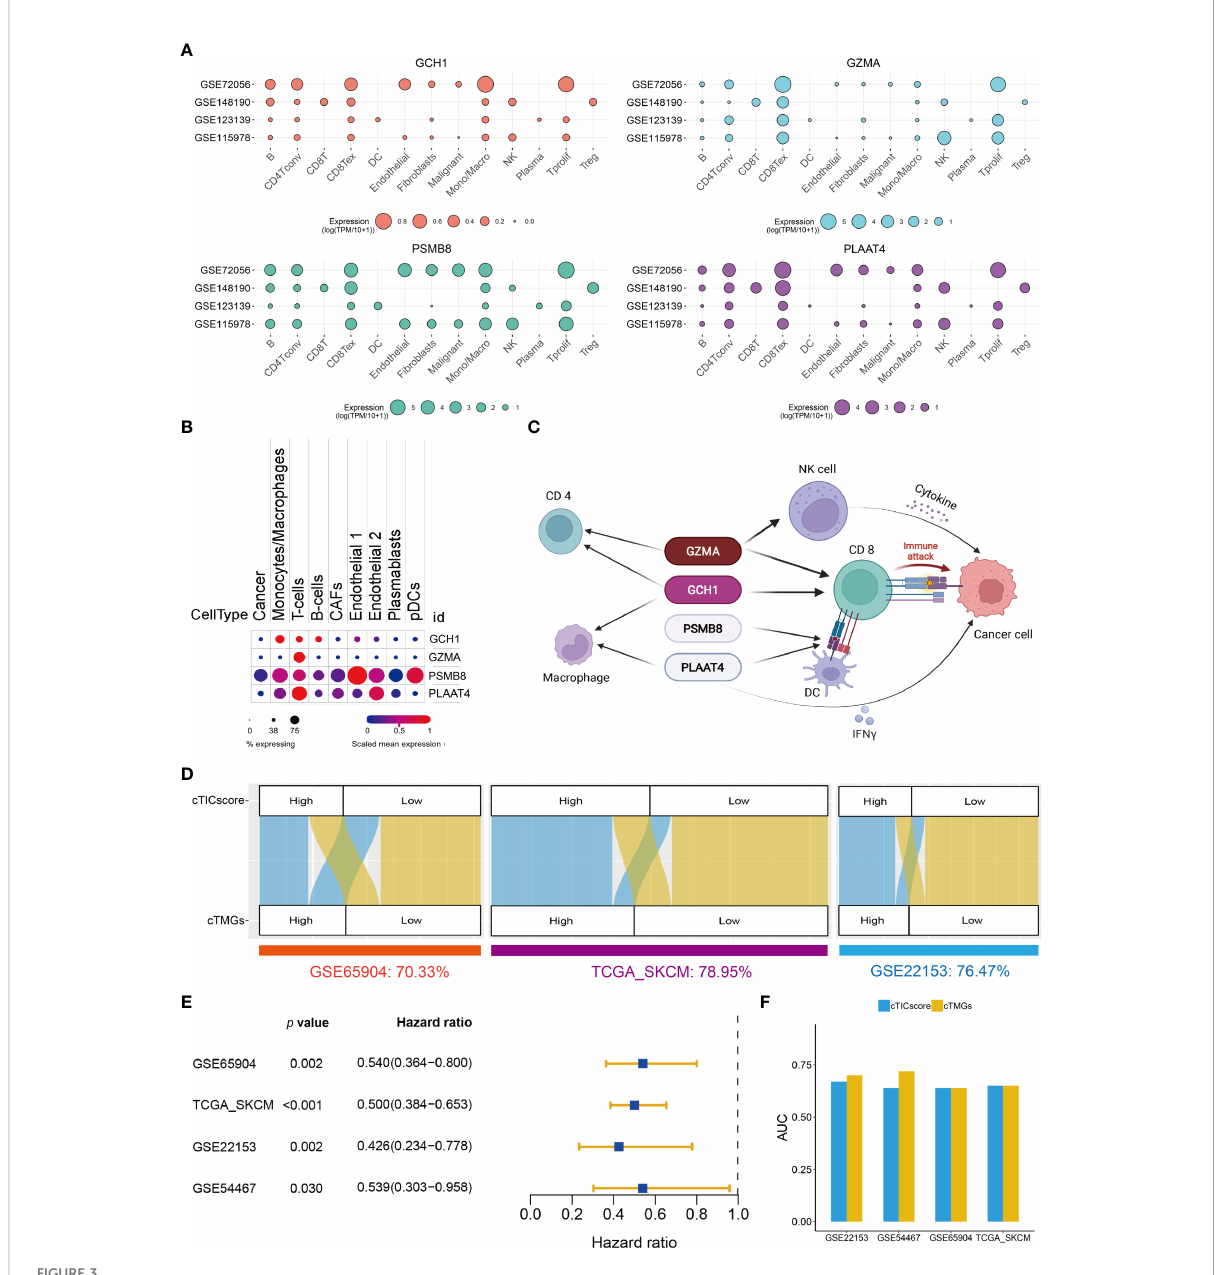
FIGURE 3 Construction of cTMGs based on four signature genes. (A) Expression of the four crucial genes in the TME components of CM. (B) Expression of the four crucial genes in different types of cells. (C) Schematic description of the potential functions of the four crucial genes in CM. (D) Relationship between cTMGs-based subtypes and cTICscore subtypes in different datasets. (E) Kaplan – Meier survival analysis results of patients in the high- and low-cTMGs groups. (F) AUC of the time-dependent ROC curves for the cTICscore and